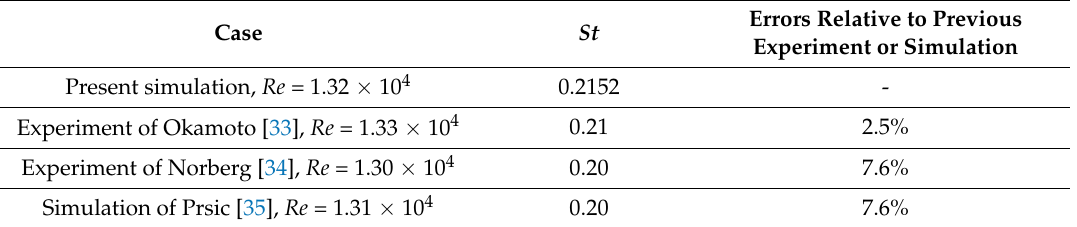
Table 2. Comparisons of Strouhal number between present simulation and experimental research. Case St Errors Relative to Previous Experiment or Simulation Present simulation, Re = 1.32 × 10 4 0.2152 - Experiment of Okamoto [33], Re = 1.33 × 10 4 0.21 2.5% Experiment of Norberg [34], Re = 1.30 × 10 4 0.20 Simulation of Prsic [35], Re = 1.31 × 10 4 0.20 7.6%